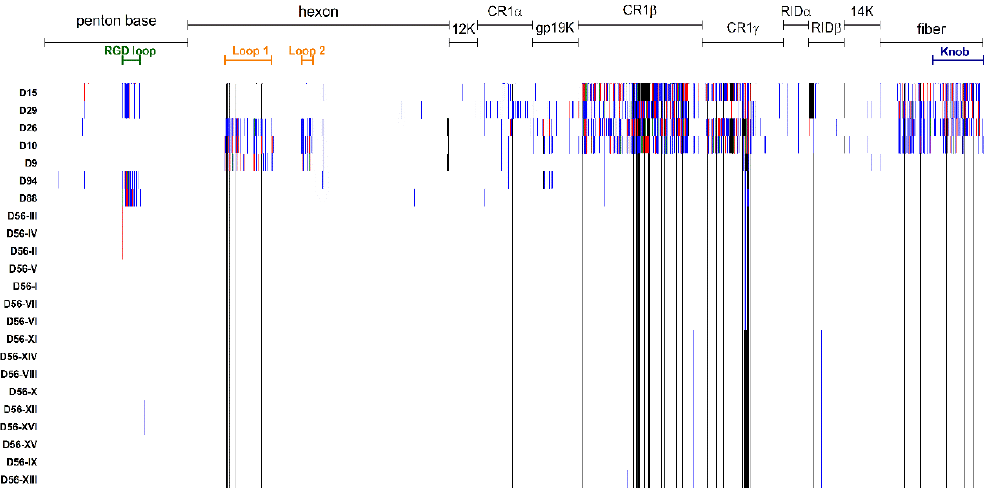
Figure 5. Proteotyping of concatenated selected protein sequences for HAdV-D56 strains I–XVI and closely related HAdV-D genotypes. The vertical axis corresponds to the compared sequences and the horizontal axis corresponds to the amino acid position in the concatenated sequences. The names of the proteins are shown on the top of the figure. The names of the sequences are annotated to the left of the figure. Sites with amino acid polymorphisms are colored accordingly with the frequency across sequences, with blank for the consensus, blue and red for the first and second most frequent polymorphisms for a position; gap sites are colored in black.